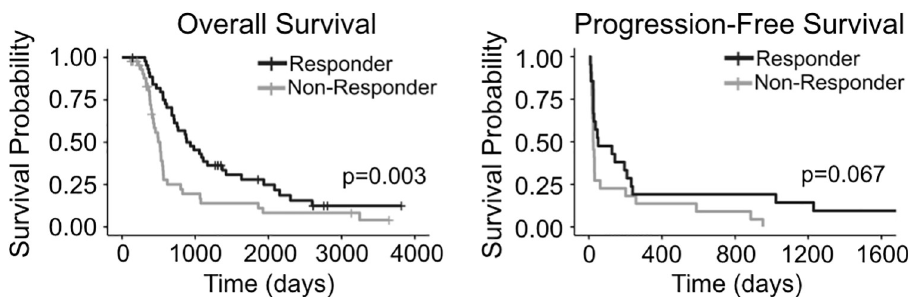
Fig 3. Survival comparison between responders and non-responders. Responders (n = 45, decrease in T1Gd volume during adjuvant TMZ) had significantly longer overall survival than non-responders (n = 45, increase in T1Gd volume during adjuvant TMZ). Among patients with dates of progression, responders (n = 21) tended to have longer times to progression than non-responders (n = 22).